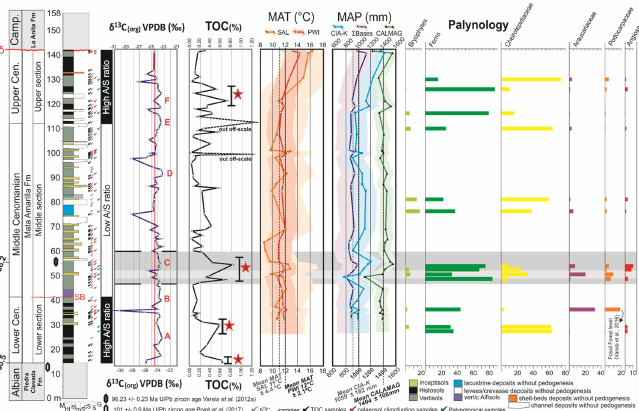
Figure 4. General stratigraphic scheme for the Mata Amarilla Formation showing organic geochemical data ( δ 13 C org and TOC), paleosol − derived geochemical climofunctions (MAT and MAP; Varela et al., 2018), and stratigraphic frequency distribution of the spores and pollen (in % of the total assemblage). Cheirolepidiaceae pollen and fern spores showed opposing stratigraphic trends. When the Cheirolepidiaceae rose in abundance, ferns decreased in their proportions, and on the contrary, when the Cheirolepidiaceae receded, ferns showed high proportions (Figure 4). Podocarpaceae and Araucariaceae were more abundant in the uppermost lower section and the base of the middle section. In the upper half of the succession, the proportions of Podocarpaceae and Araucariaceae decreased significantly. Angiosperm proportions were low throughout the succession (0.4–1.5%), with the highest proportion concentrated toward the base of the middle section (6.8–13.8%) (Figure 4).